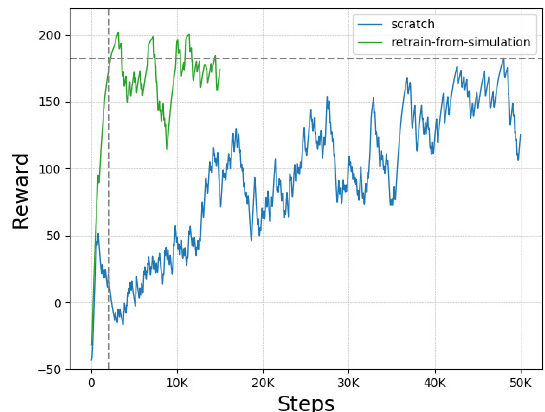
Figure 10. Comparison between learning from scratch and learning from a policy learned in the simulation: learning curve for the 3D-printed cuboid-peg insertion task in a real robot with random initial positions.